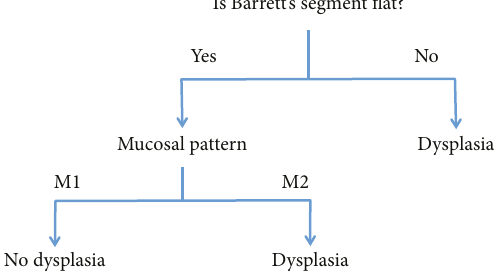
Table 1: Comparison of sensitivity and speci fi city between cases before and after acetic acid for all 3 experts. ND-BE: no dysplasia; D-BE: dysplasia. Before acetic acid Sensitivity, % (95% C.I.) Negative predictive value, % Sensitivity, % (95% C.I.) Negative predictive value, %